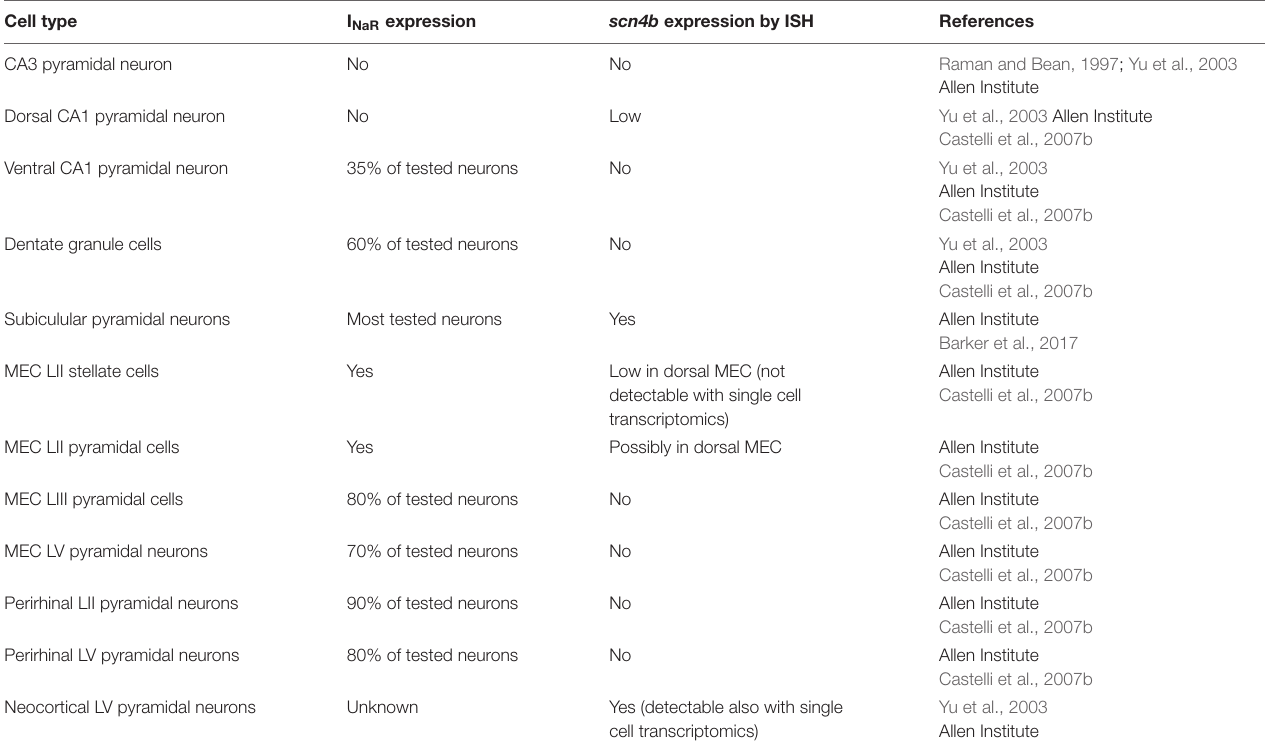
TABLE 1 | Cell-types where I NaR expression and/or scn4b has been investigated. Cell